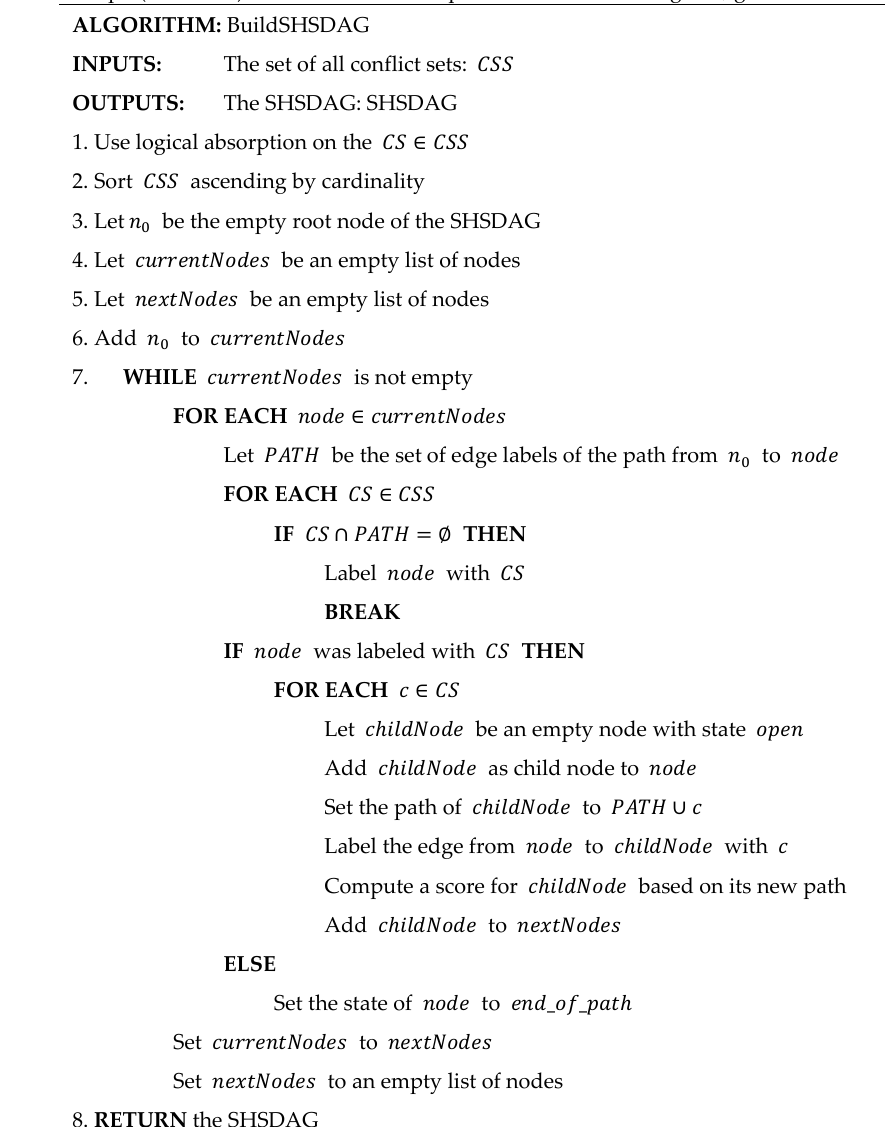
Algorithm 4. Pseudo code of the BuildSHSDAG-function used to build a Scored Hitting Set Directed Acyclic Graph (SHSDAG) and therefore to compute the minimal hitting sets, given a set of conflict